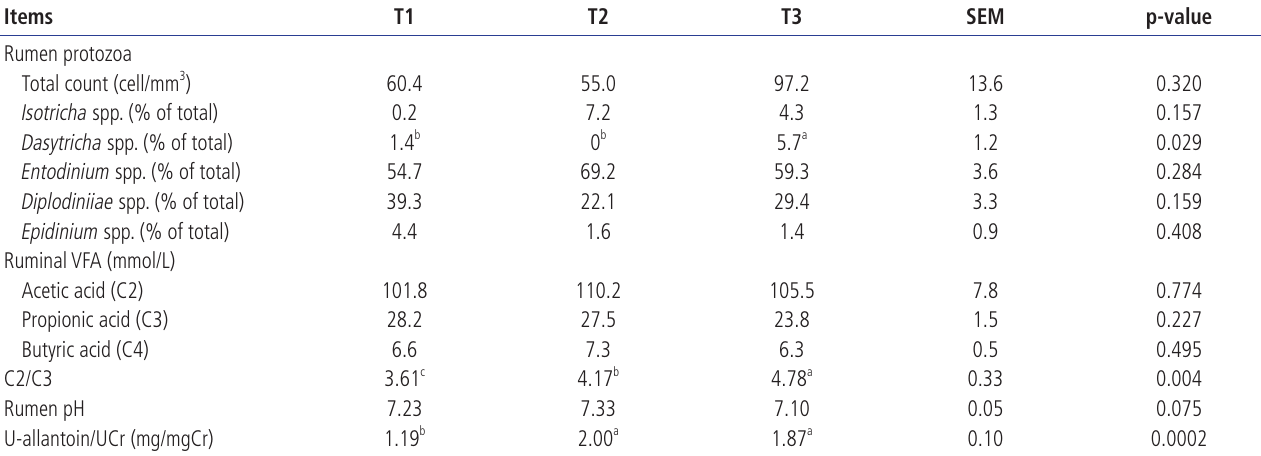
Table 4. Ruminal protozoa and volatile fatty acid contents and urinary allantoin creatinine ratio in goats fed three different diets Items